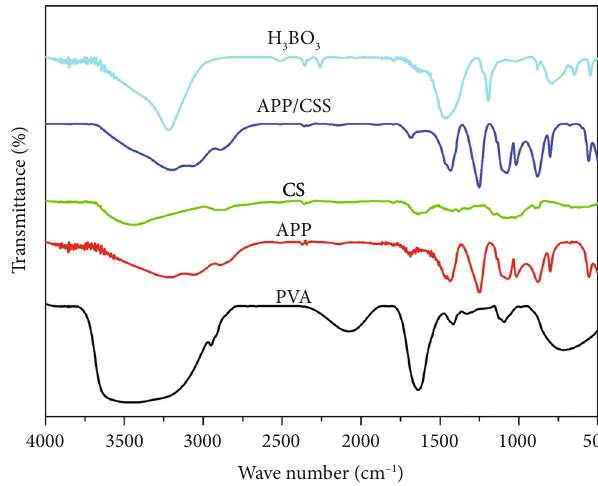
Figure 2: FTIR spectra of PVA, APP, CS, APP-CS, and H